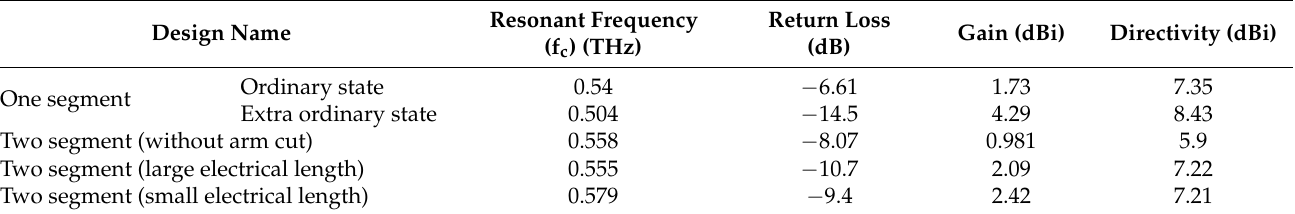
Table 2. Parametric comparison of different geometries of the fractal antenna at resonant